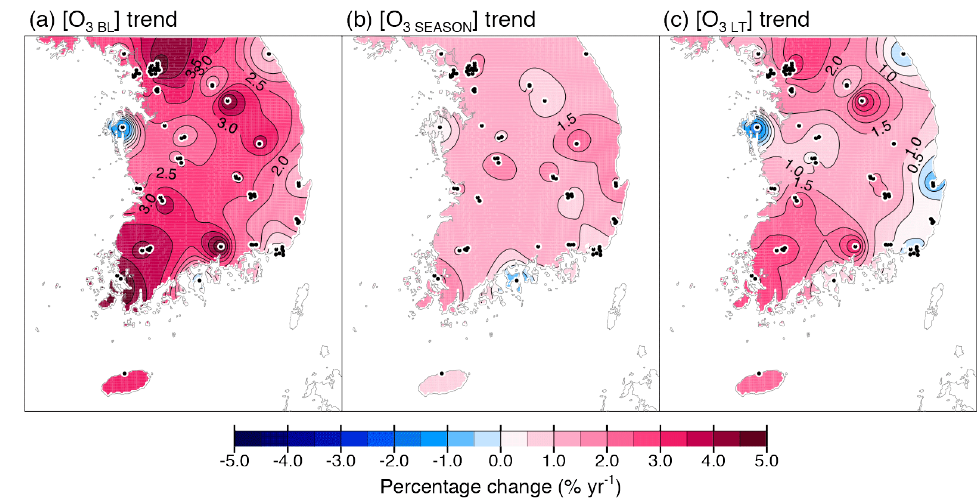
Figure 13. Spatial distributions of temporal linear trends of the (a) baseline ([O 3BL ]), (b) seasonal component ([O 3SEASON ]), and (c) long-term component ([O 3LT ]) for the period 2000–2009 using data from 72 air quality monitoring sites of